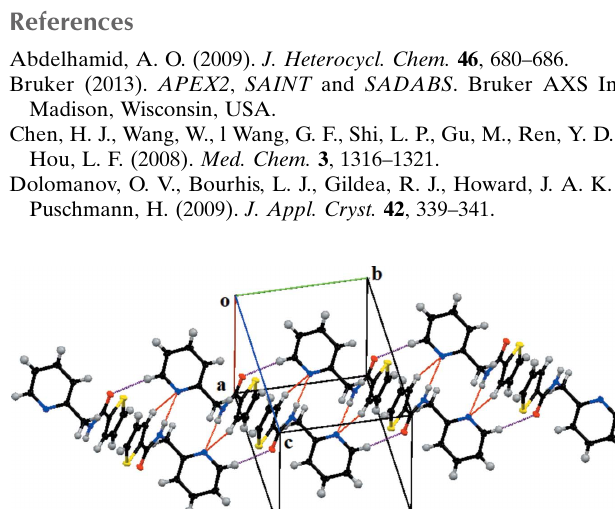
Figure 2 An inversion dimer with graph-set motif R 2 H (cid:3)(cid:3)(cid:3) N hydrogen bonds. The bottom molecule is generated by the symmetry operation (cid:4) x + 1, (cid:4) y + 1, (cid:4) z + 1.